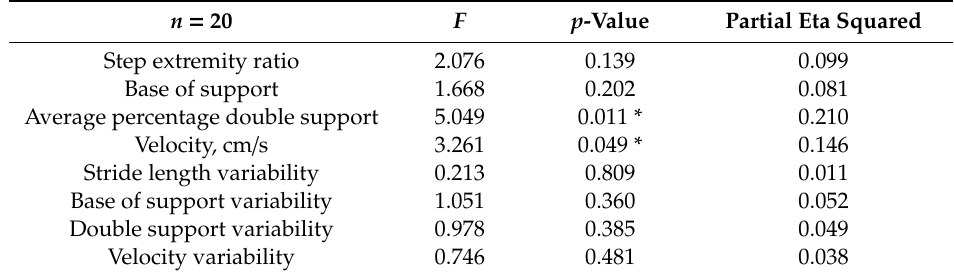
Table 2. Main e ff ects and e ff ect sizes of the hallway width manipulations on spatiotemporal and variability parameters of